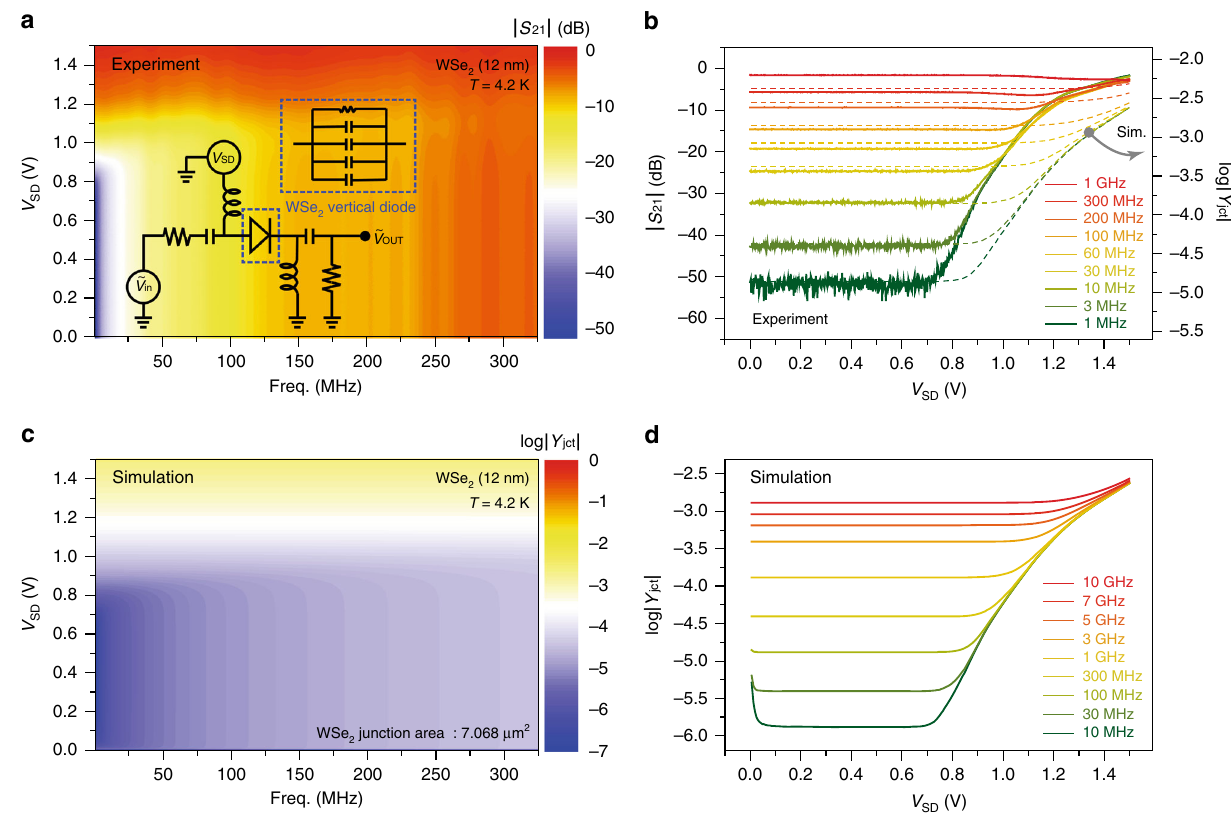
Fig. 5 High-frequency switching operations of WSe 2 vertical diodes. a Two-dimensional display of the forward transmission coef fi cient (| S 21 |) at varying V T = 4.2 K from the vertical diode with t ≈ 12 nm as a p – i – n junction thickness. High-frequency switching with SD and a driving frequency measured at WSe 2 a threshold bias at V SD ≈ 0.8 V is observed up to f ≤ 300 MHz. (inset) Scattering parameters are monitored through a 50- Ω network with a bias tee supplying DC currents and high-frequency inputs. Switching operations are determined by the junction resistance and the parallel connected capacitances. b High-frequency switching characteristics (| S 21 |) at varying frequencies. The calculated junction admittances ( Y jct ) are plotted as dotted lines, proving that the parasitic signal loss through the Si/SiN substrate limits the high-frequency operations in our WSe 2 vertical diodes. c , d Two-dimensional display ( c ) and line pro fi les ( d ) of simulated junction admittances with the sole consideration of the active WSe 2 vertical junction area of 7.068 μ m 2 , presenting the possibility that 2D vdW vertical diodes can be utilized in high-frequency switching